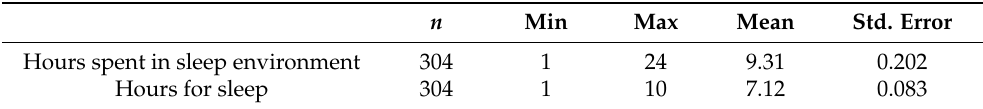
Table 6. Hours spent in the sleeping environment and during sleep.